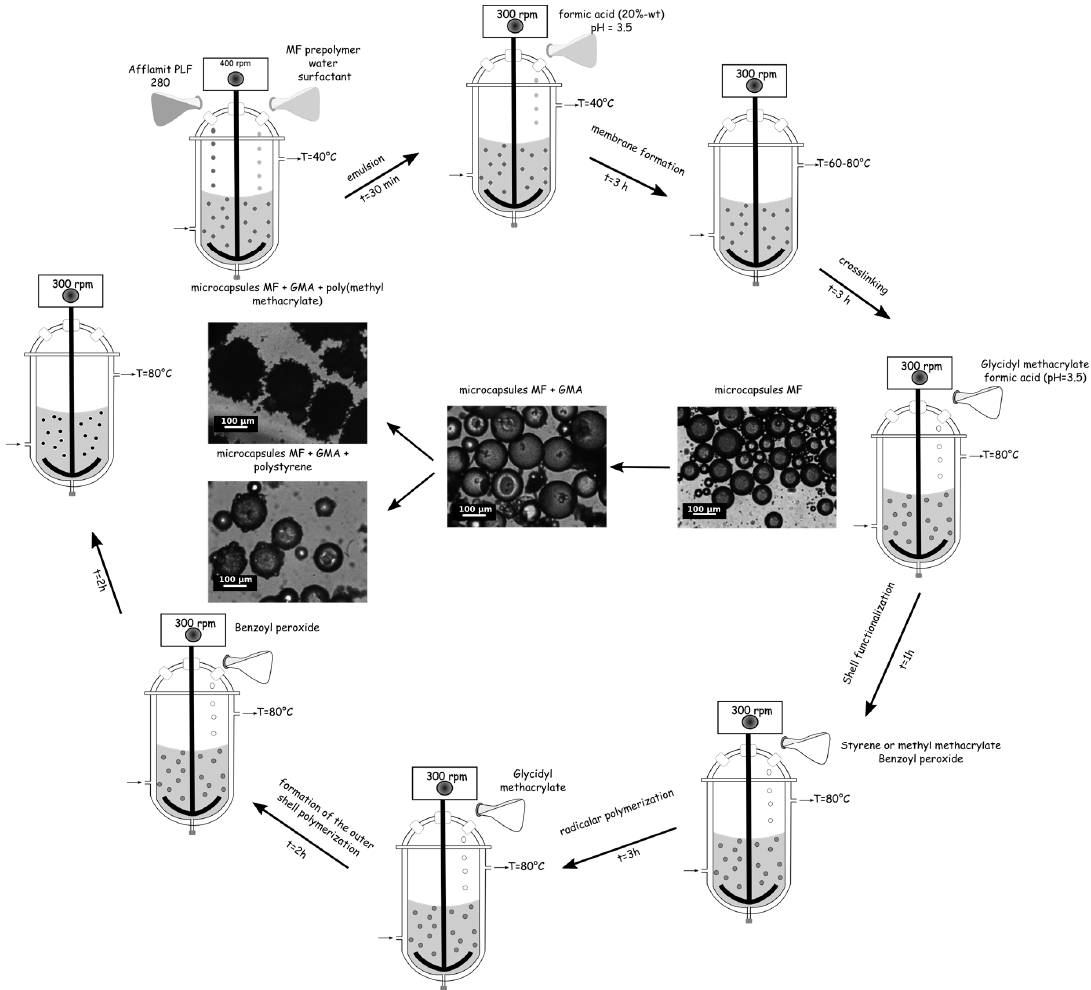
Figure 1. Schematic representation of the microencapsulation process.